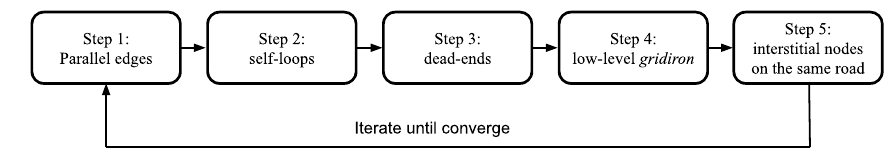
Fig. 2 The five-step simplification framework and components being removed in each